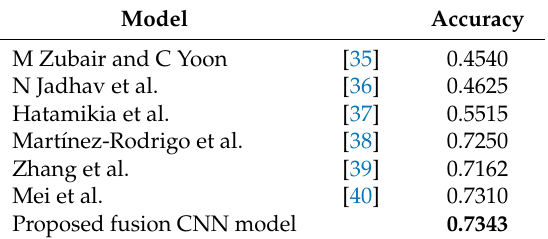
Table 6. Four class classification performance.